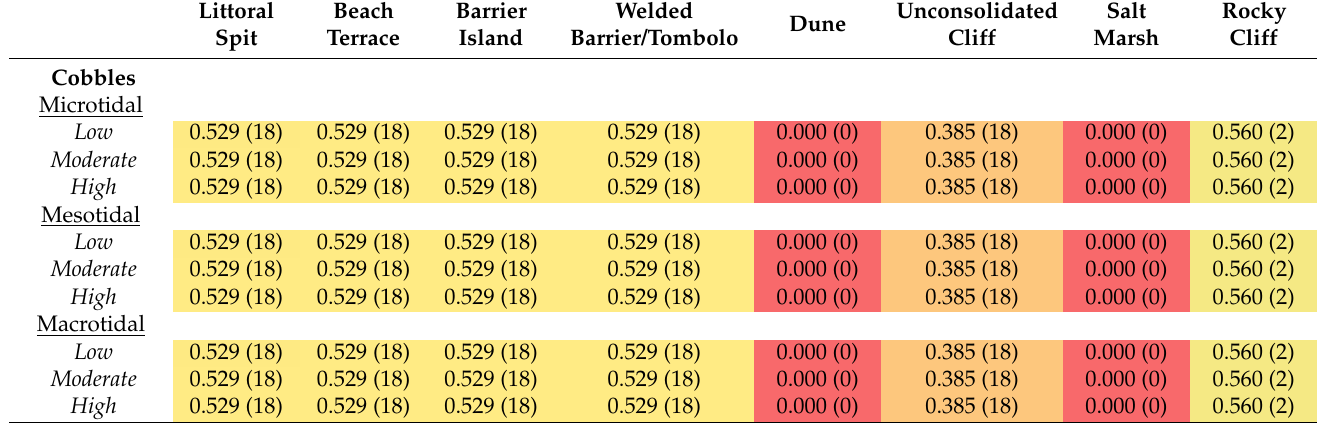
Table 13 to contextualize the averaging